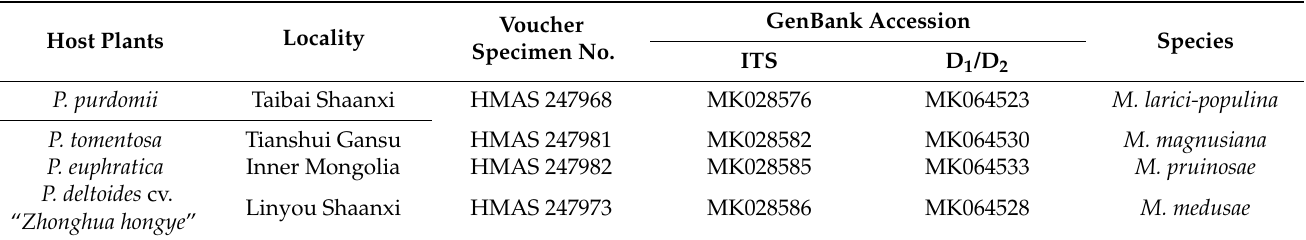
Table 1. Four samples of Melampsora in this study, with host plants, sampling locations, voucher, and GenBank accession